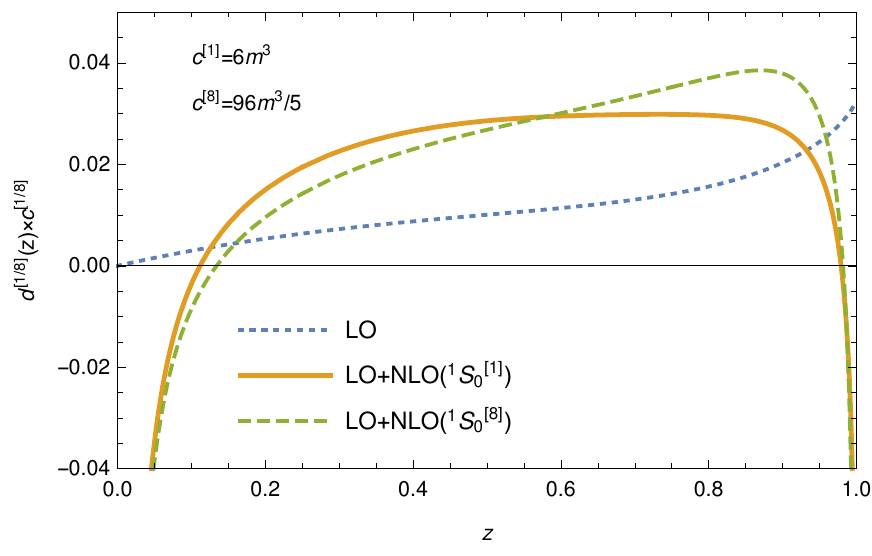
) at LO and NLO. 0 (cid:0) (cid:1) d [1] ( z )+ d [1] ( z ) (cid:2) LO NLO